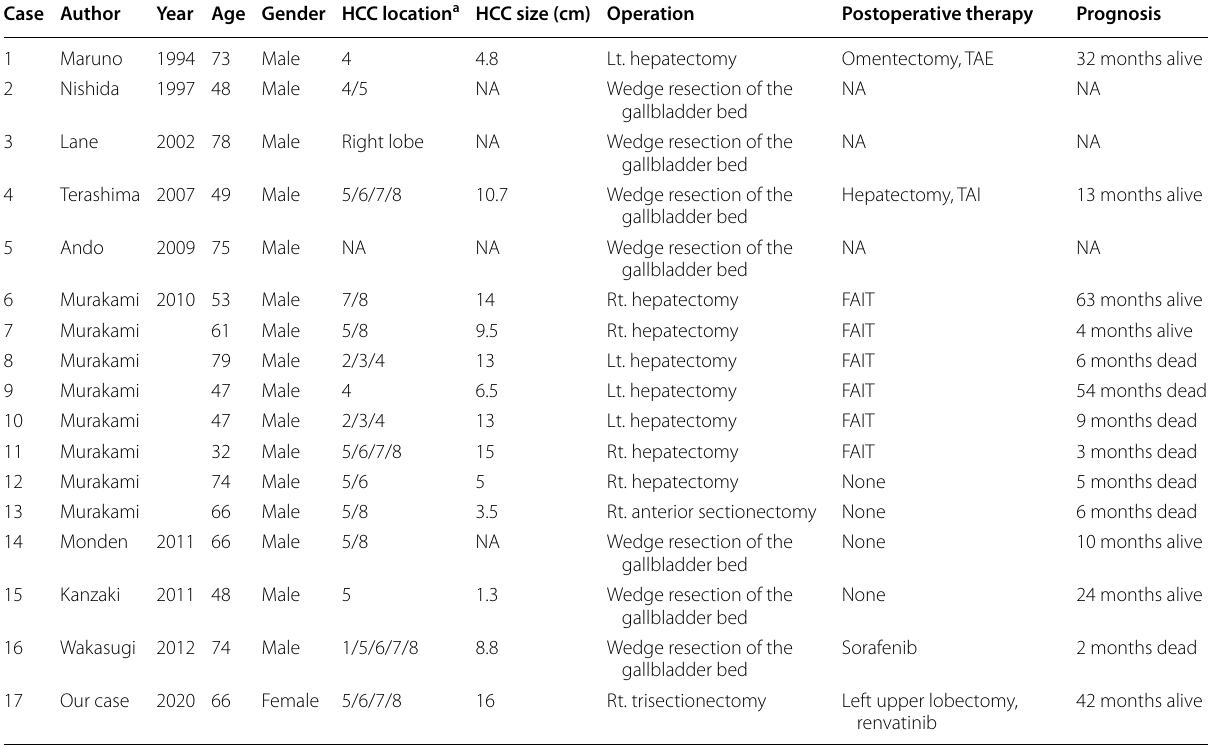
HCC hepatocellular carcinoma, GB gallbladder, FAIT intra-arterial infusion of 5-FU and subcutaneous interferon-alpha injection therapy a Numerals indicating Couinaud’s segment of the